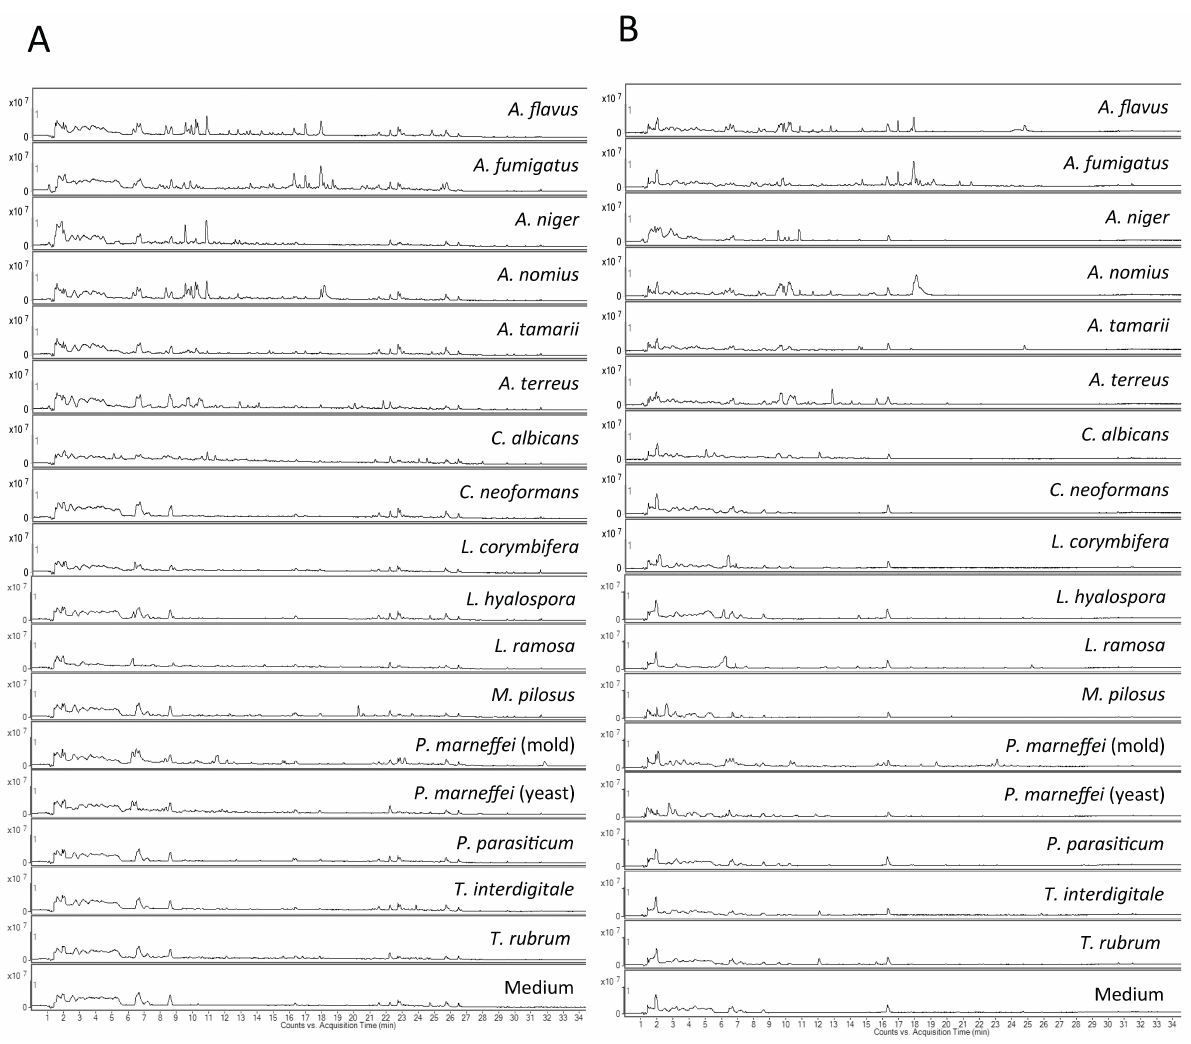
Figure 1. Total ion chromatograms of Aspergillus species and other control fungal species used in this study. ( A ) Positive ionization mode; ( B ) Negative ionization